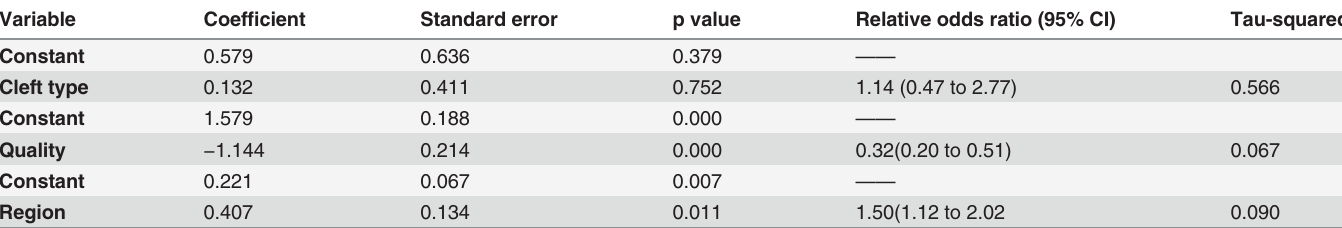
Table 2. Univariate meta-regression analysis relating cleft type and study quality to effect size estimates of the relation between passive smoking and NSOFC.